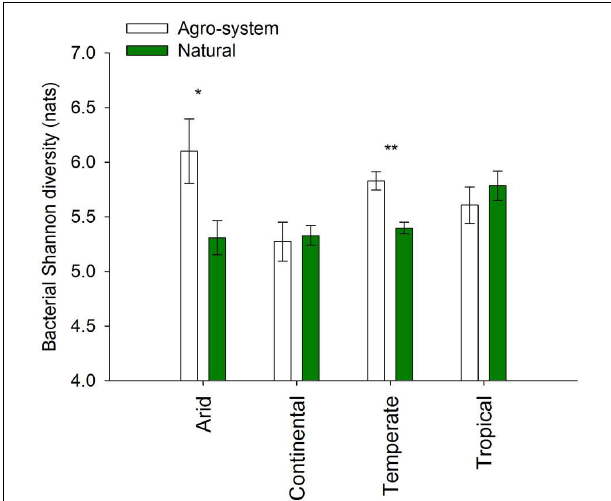
FIGURE 4 | Bacterial Shannon diversity of agricultural vs. natural systems in arid ( n = 26 and 70), continental ( n = 43 and 119), temperate ( n = 82 and 128) and tropical ( n = 14 and 36) regions. The sites were selected based on a meta-analysis consisting of both published and unpublished data wherein bacterial diversity and compositions is described based on next generation sequencing techniques (either 454 or Miseq; see Material and Methods for more details). The main climate classes are based on global maps available for the most frequently used Köppen climate classification map (Kottek et al., 2006). ∗ P < 0.01; ∗∗ P <